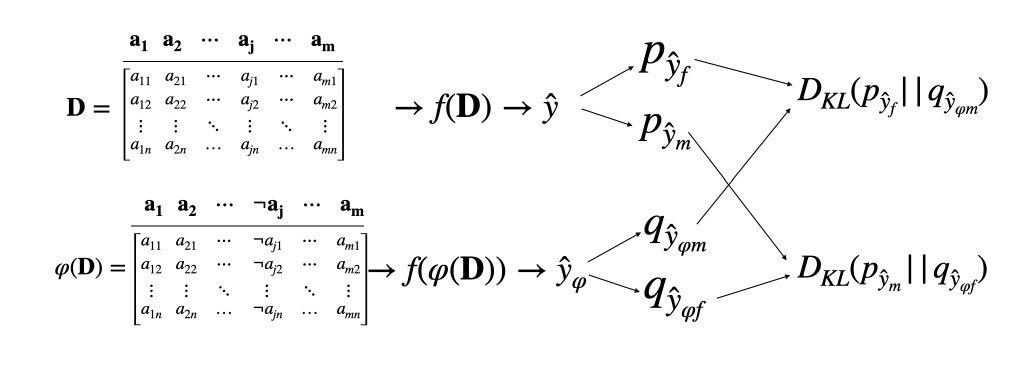
Figure 1. KL divergence for bias